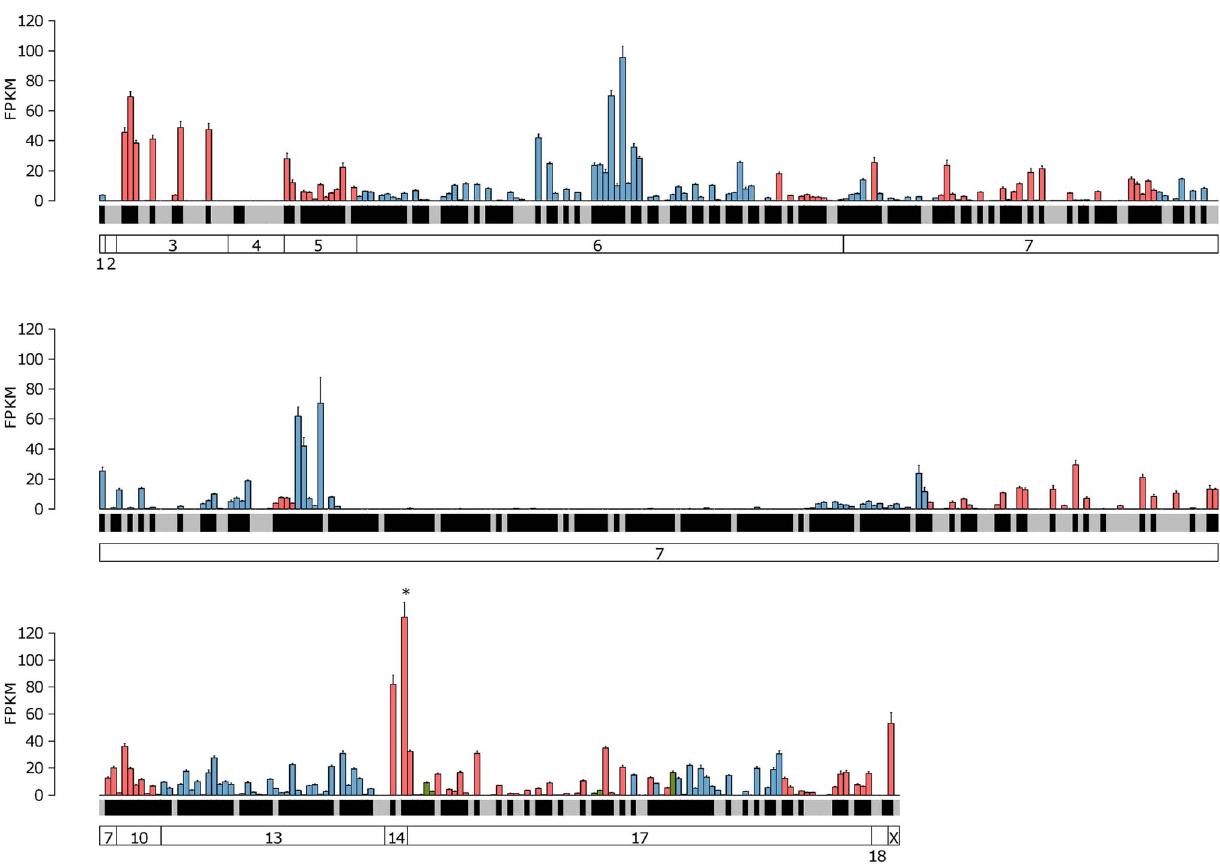
Figure 4. Expression of the complete VR repertoire in the VNO. The mean FPKM expression values are shown for all the VR and formyl peptide receptor (FPR) genes in the VNO. Genes are ordered by their chromosomal location and chromosomes are annotated in the boxes at the bottom. V1R genes are blue, V2R genes are red and FPR genes are green. Black shading below each bar indicates the gene is annotated as a functional receptor, and grey indicates an annotated pseudogene. Error bars represent the standard error of the mean from the six biological replicates. Vmn2r89 is the highest VR gene expressed and is indicated with an asterisk.